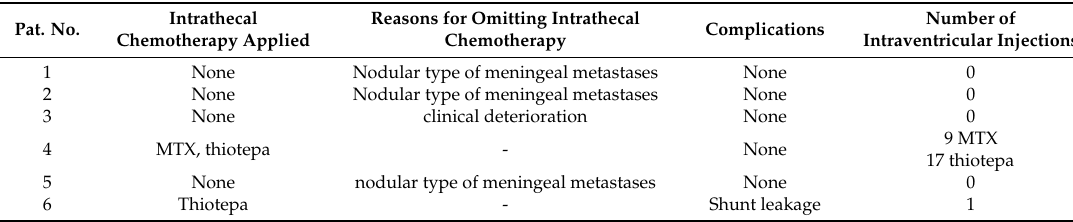
Table 1. Intrathecal chemotherapy.